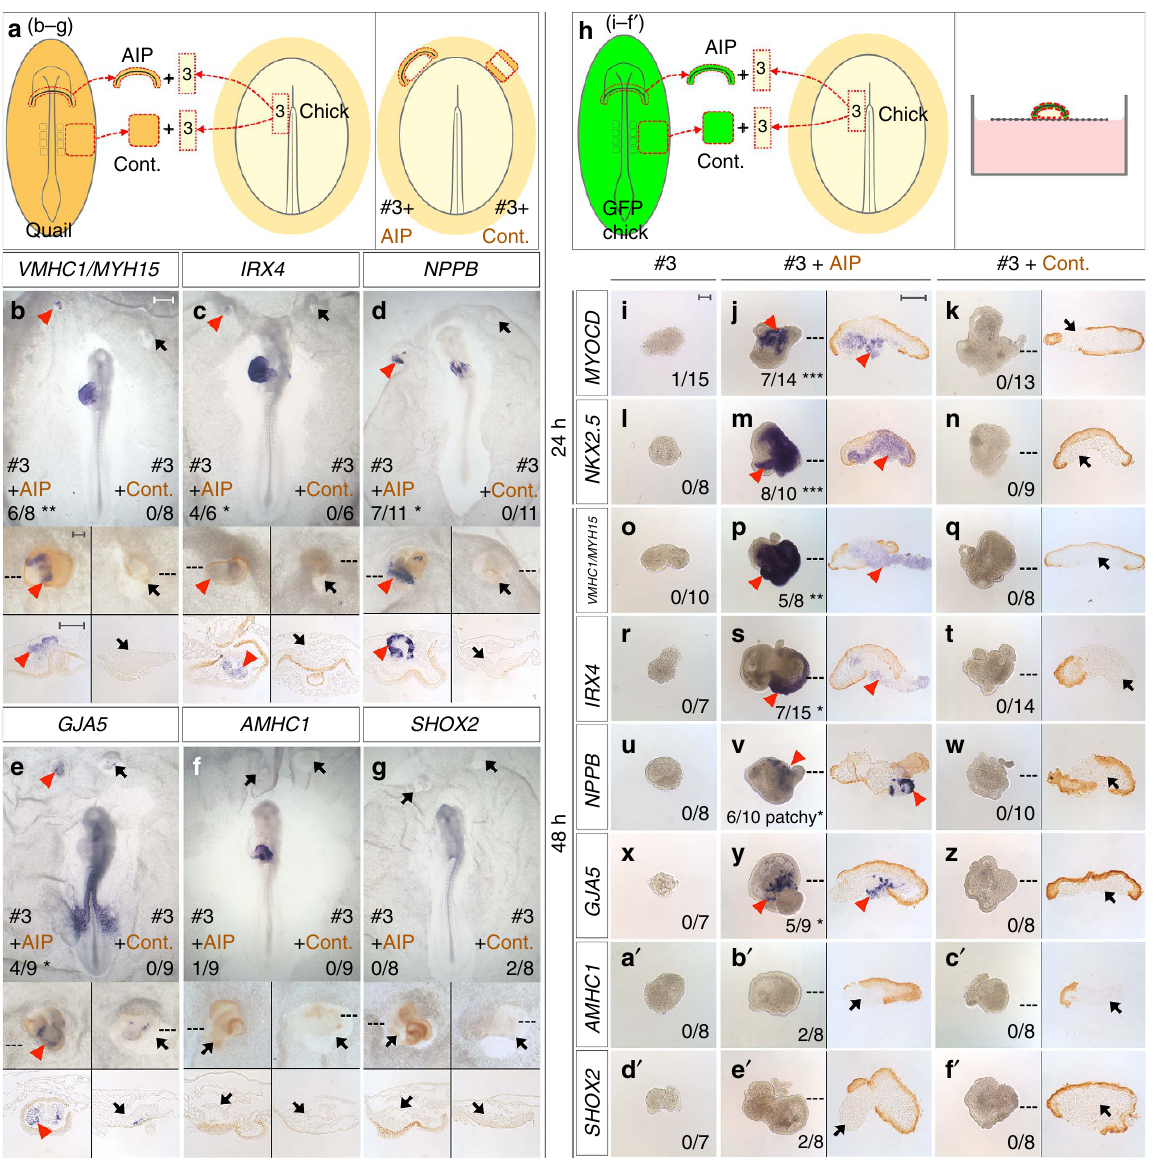
Figure 2 | AIP induces cardiac and ventricular identity in non-cardiac mesoderm. ( a ) AIP or control (Cont.), lateral endoderm from a HH8 quail co-cultured with anterior-medial mesoderm (#3) from a HH5 chick embryo overnight in the anterior area opaca of a host chick. ( b – g ) Regional myocardium markers VMHC1/MYH15 ( b ), IRX4 ( c ), NPPB ( d ) and GJA5 ( e ) are induced in #3-mesoderm by quail (brown) AIP (red arrowheads), but not by control endoderm (Cont., black arrows), whereas AMHC1 ( f ) and SHOX2 ( g ) are not induced (black arrows). ( h ) In vitro co-culture of #3-mesoderm with GFP-AIP ( j , m , p , s , v , y , b’ , e’ ) or -Cont. ( k , n , q , t , w , z , c’ , f’ ) for 24 ( j , k , m , n ) or 48h ( p , q , s , t , v , w , y , z , b’ , c’ , e’ , f’ ). No expression is seen in #3-mesoderm cultured alone ( i , l , o , r , u , x , a’ , d’ ). AIP (brown) induces MYOCD ( j ), NKX2.5 ( m ), VMHC1/MYH15 ( p ), IRX4 ( s ), NPPB ( v ) and GJA5 ( y ) in #3-mesoderm (red arrowheads), but Cont. does not (brown, k , n , q , t , w , z , black arrows). Neither AMHC1 nor SHOX2 are induced (black arrows) by AIP ( b’ , e’ ) or by Cont. ( c’ , f’ ). * P r